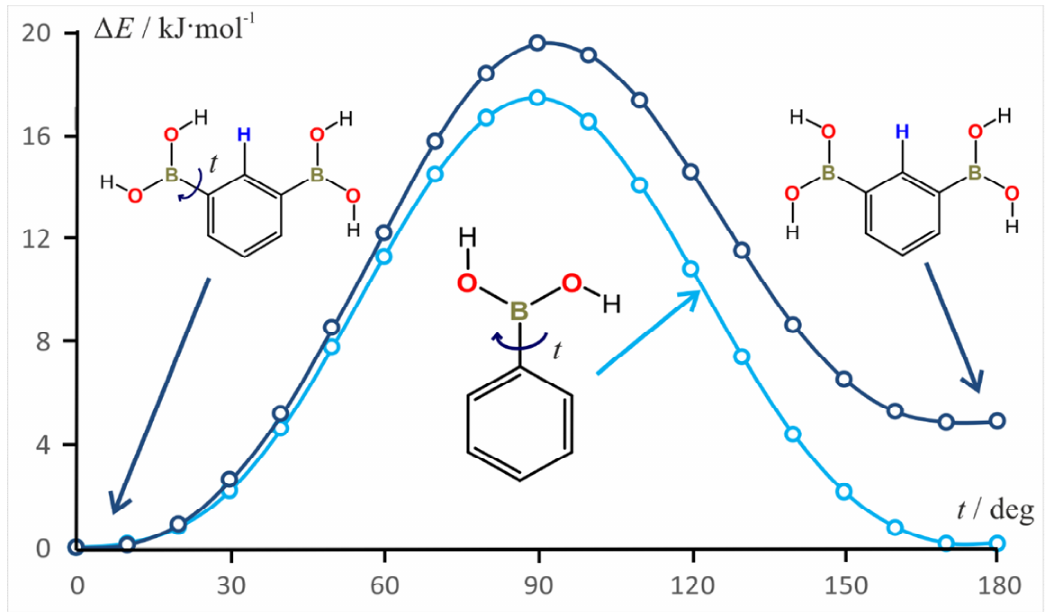
Figure 10. The energy profile for rotation of one boronic groups in respect to the phenylene ring fragment in phenylboronic acid (light blue) and m -phenylenediboronic acid (navy blue). The dihedral angle of the second boronic group is fixed to 0°.